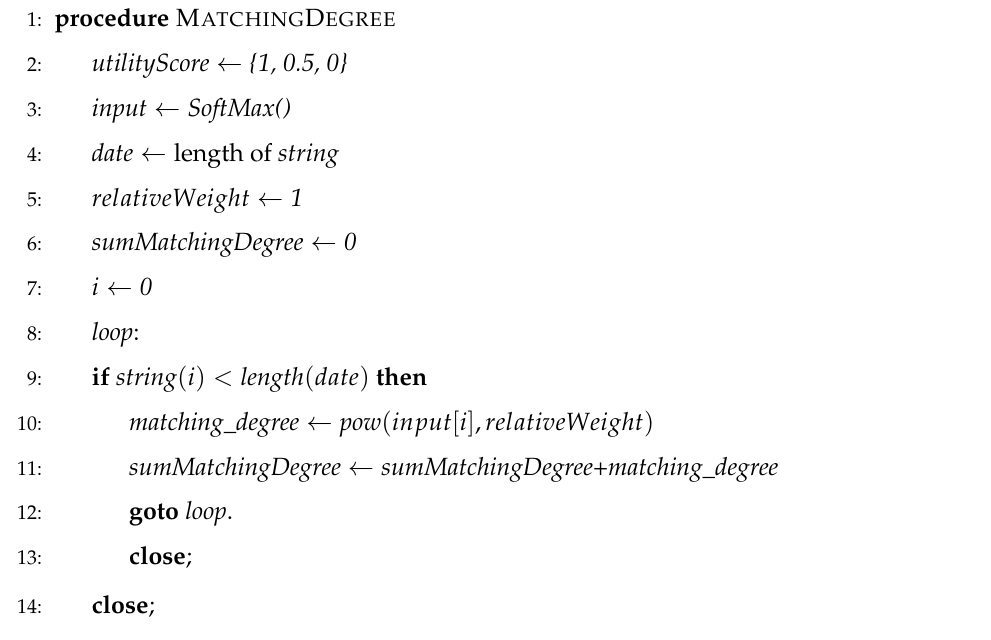
Algorithm 1 Process of calculating matching